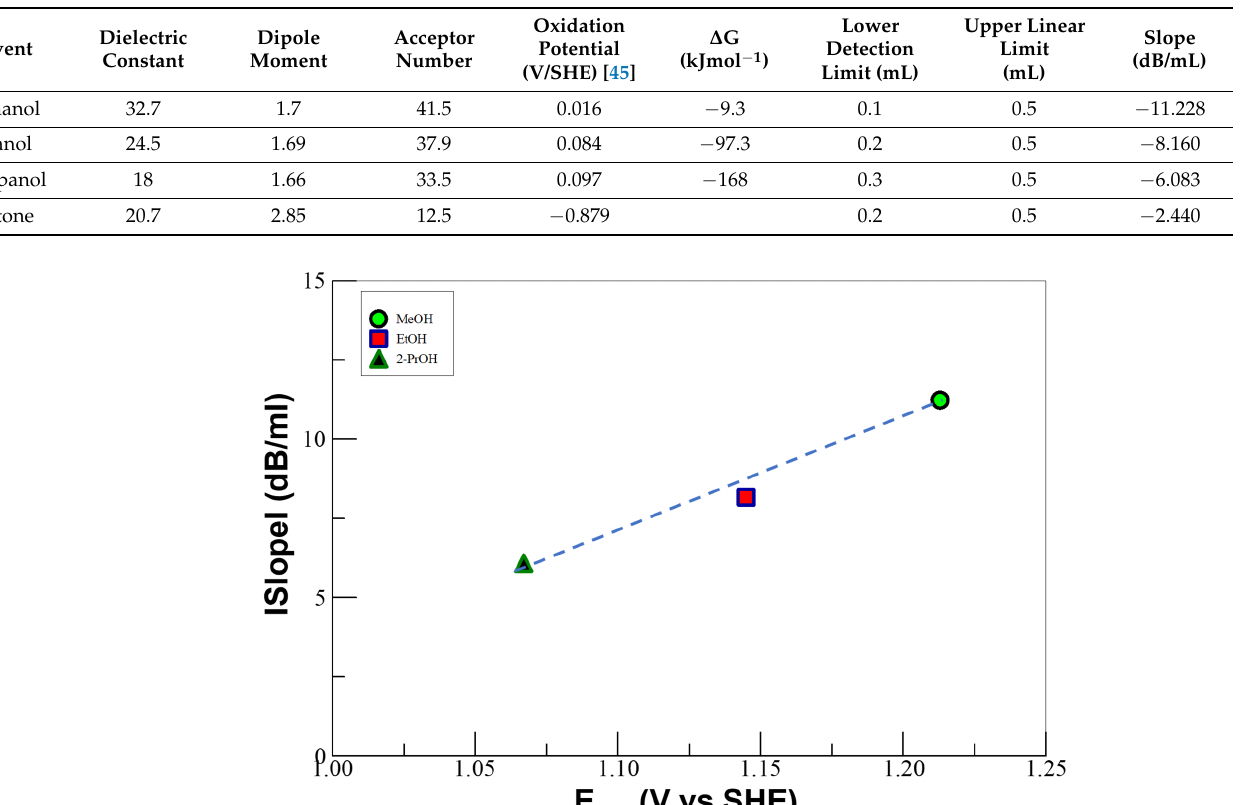
Table 1. Summary of |S 21 |-concentration plot features, and some salient physico-chemical properties of neat analytes.